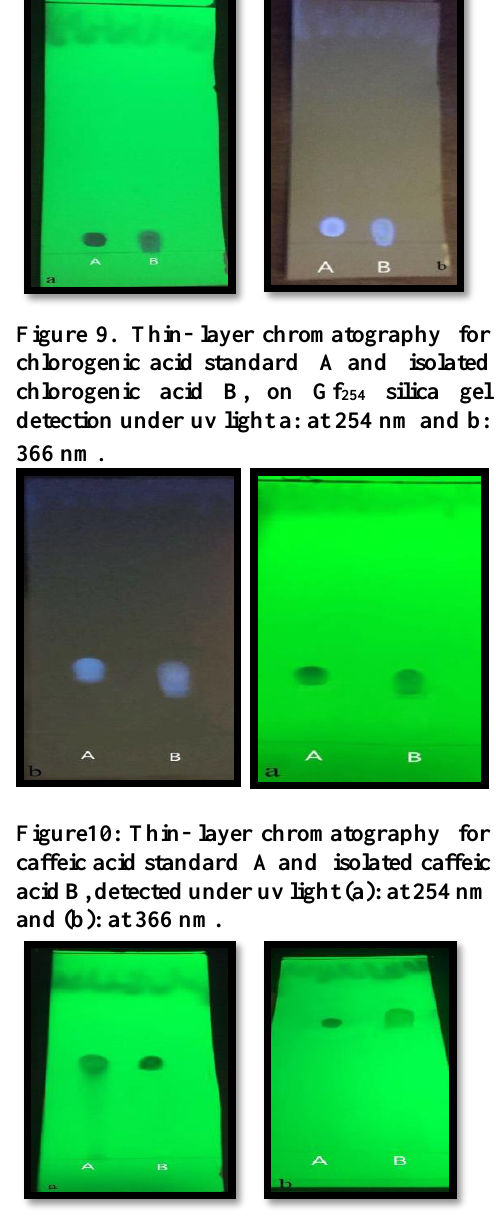
Figure.11. Thin- layer chromatography for ( a) : luteolin isolated A and standard luteolin B, (b) resorcinol standard A and isolated resorcinol (B) on GF 254 silica gel revealing under 254 nm uv light FTIR Analysis for the isolated compounds The FTIR spectral analysis of separated chlorogenic acid compound show peaks at 3600, 3400-3200, 1680, 1640, 1600,